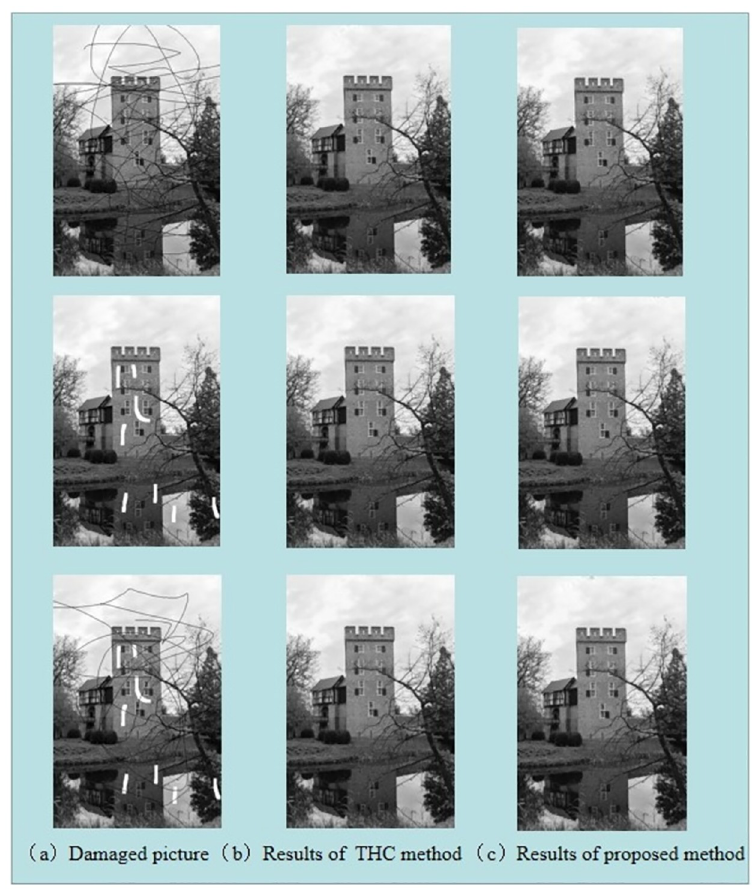
Fig 8. The inpainting results for corrupted images of ‘Castle’. (Different from the original picture ‘Cameraman’, it is only for illustrative purposes).